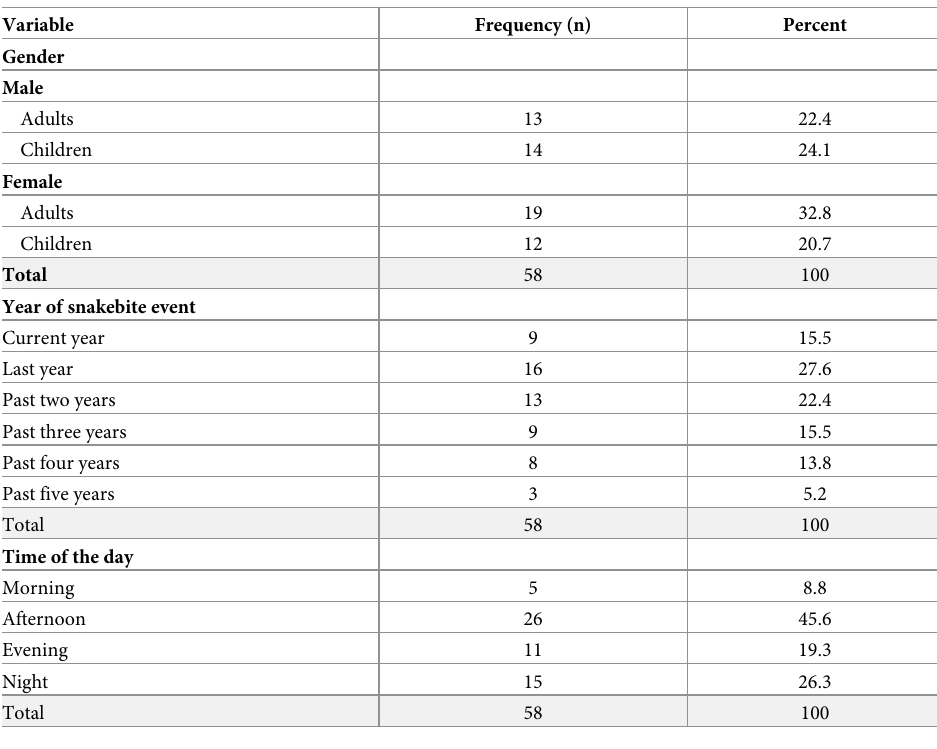
Table 2. The distribution of household cases of snakebite in the Meserani Juu (N = 58). Variable Frequency (n)